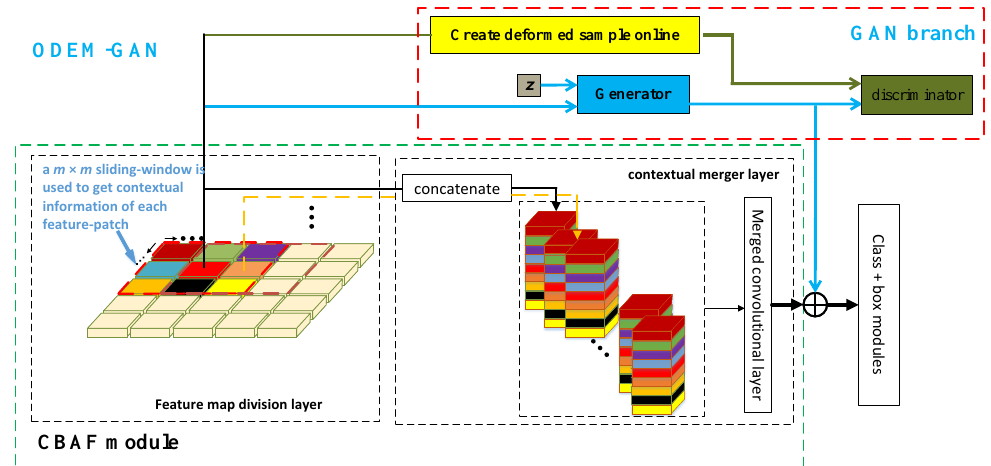
Figure 7. ODEM-GAN module includes a CBAF module (in the green-dashed box), a GAN branch (in the red-dashed box).